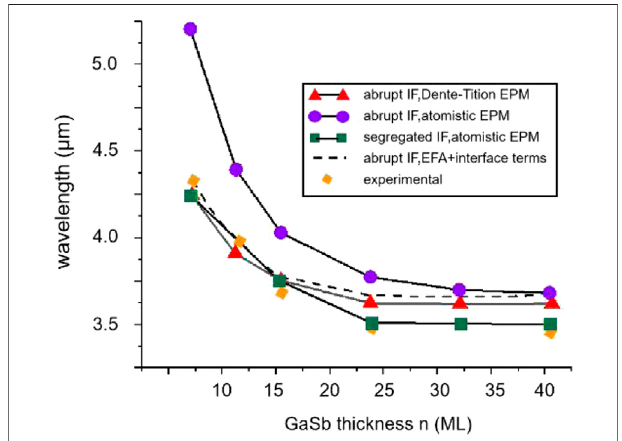
FIGURE 8 | Comparison of the experimental data (solid diamonds) for the(InAs) 8 /(GaSb) n Cut-offwavelengthswiththevaluesgivenby(a)theEPMof Dente et al. (solid triangles) and by the EPM for superlattices with abrupt (solid circles) and segregated (solid squares) interfaces.